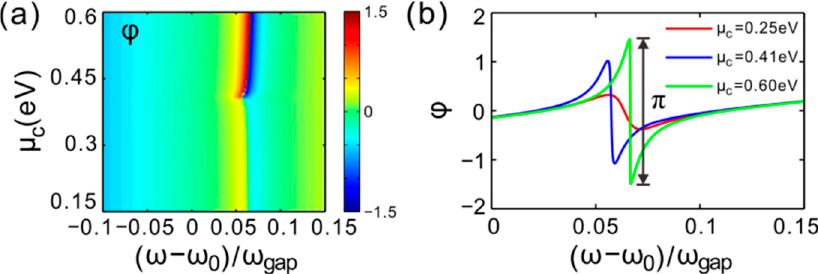
Figure 6. ( a ) The phase of the reflection coefficient. The parameter space composed of the chemical potential and normalized frequency. ( b ) The reflection coefficient phase varying with the normalized frequency. The Bragg periodic number N =